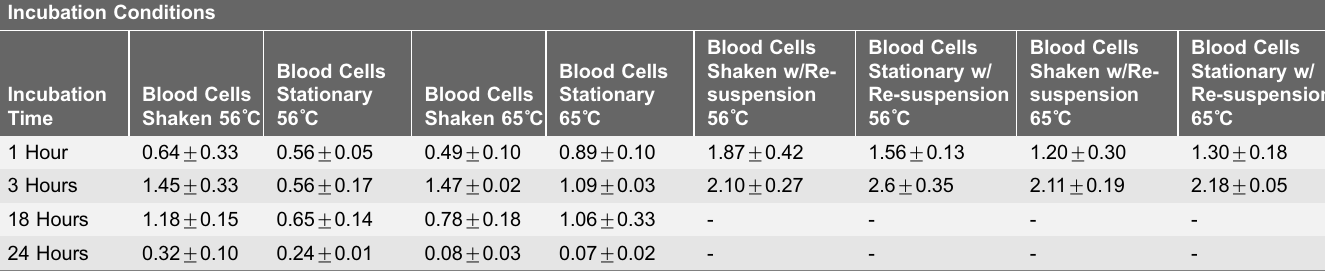
Table 3. Average DNA quantitation values 1 for experiments with blood